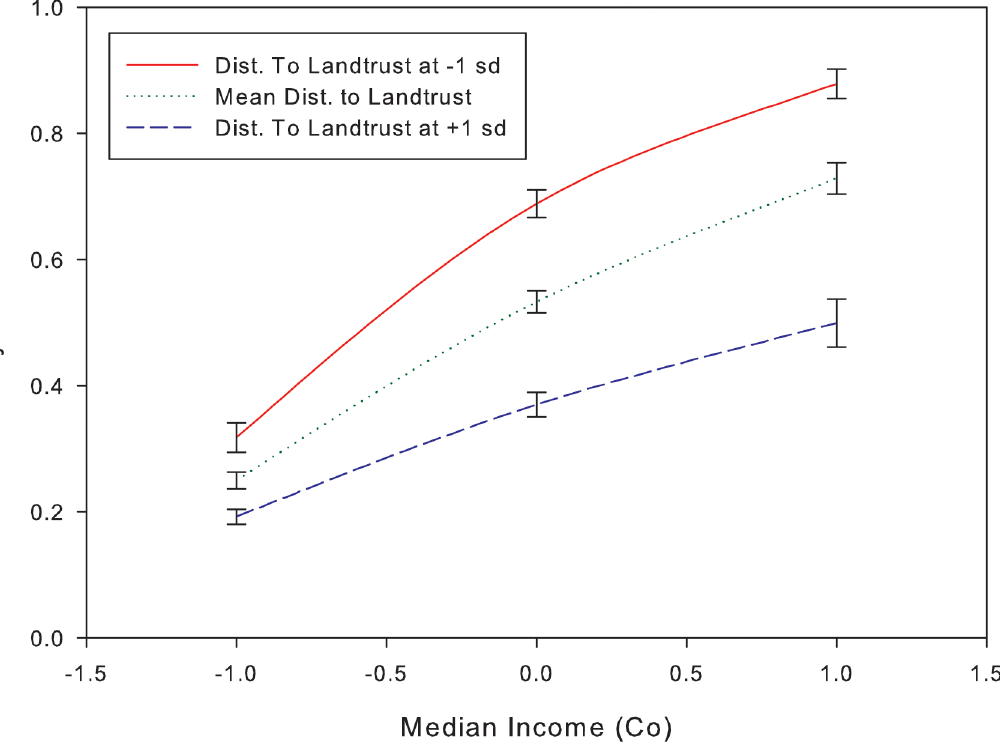
Fig 4. The interaction effect of distance to nearest land trust address on median county income for predicting conservation easement location. The closer an easement was to a land trust, the greater the positive effect of income; easement locations farther from a land trust were associated with higher incomes, but the effect was